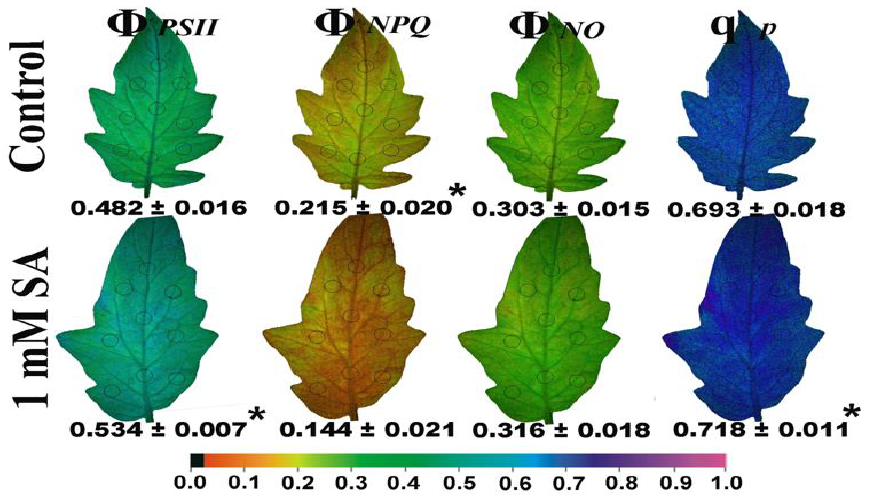
Figure 5. Representative color-coded images under actinic light (AL) of 205 µ mol photons m − 2 s − 1 , (LL), of the effective quantum yield of PSII photochemistry ( Φ PSII ), the quantum yield of regulated non-photochemical energy loss in PSII ( Φ NPQ ), the quantum yield of non-regulated energy loss in PSII ( Φ NO ), and the fraction of open PSII reaction centers (q p ) of tomato leaflets after 72 h of foliar spray by either distilled water (control) or 1 mM salicylic acid (SA). The areas of interest (AOI) are shown in circles with values for each chlorophyll fluorescence parameter for the whole leaflet (average ± SD) are given. The color code showed at the bottom ranges from values 0.0 to 1.0. An asterisk indicates statistically significant difference ( p < 0.05).